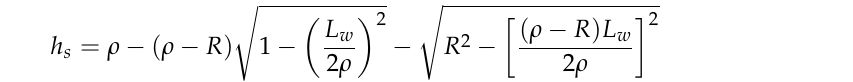
Figure 7. Effects of machining strategies on the surface roughness of a micro-lens array mold.